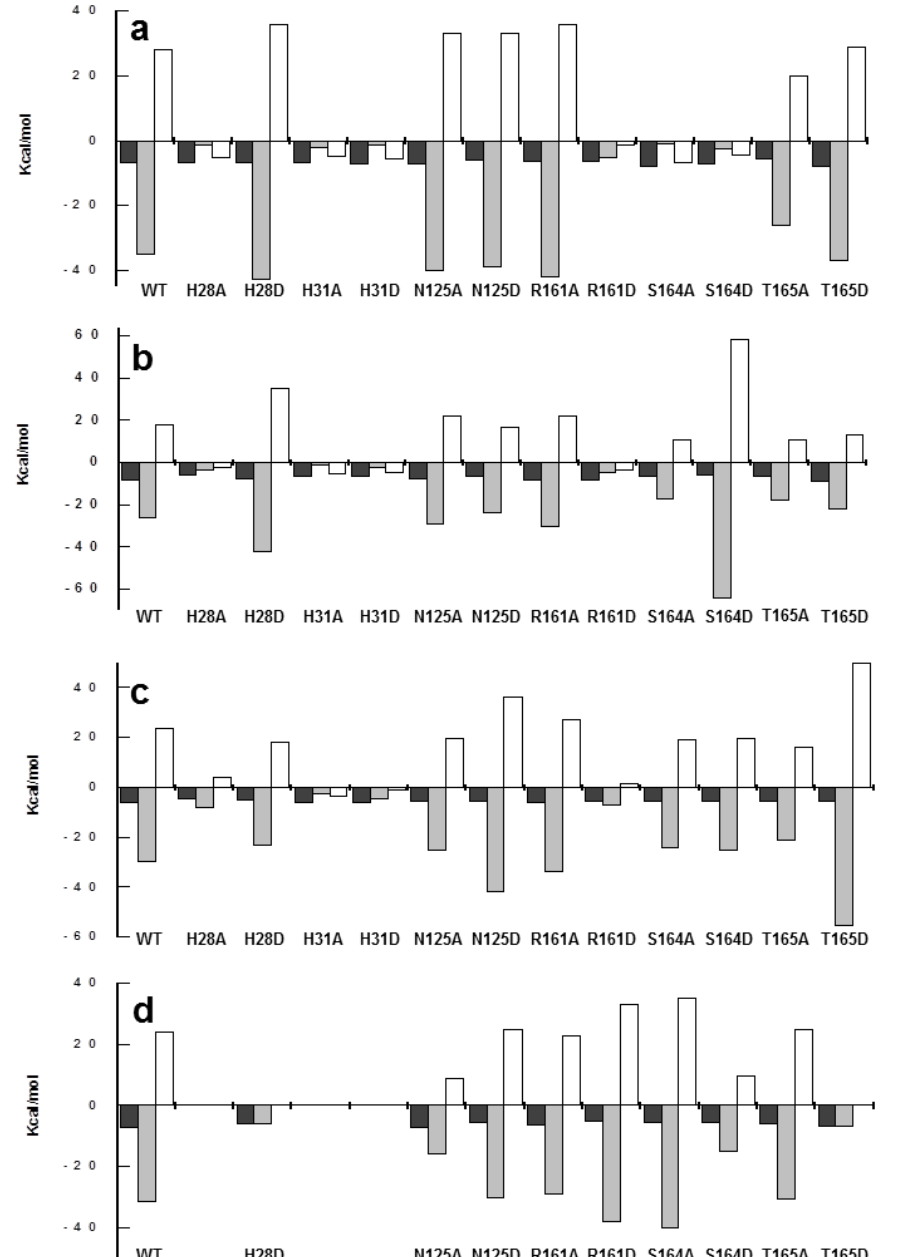
Figure 4. Thermodynamic dissection of the interaction of the Ca FADS forms with ( a ) FMN, ( b ) FAD and ( c , d ) ATP. The binding Gibbs energy (Δ G ), enthalpy (Δ H ), and entropy (−TΔ S ) are represented by dark grey, light grey and white bars, respectively. Conditions are: 20 mM PIPES, 10 mM MgCl , pH 7.0 for ( a – c ) and in absence of MgCl 2 2 for ( d